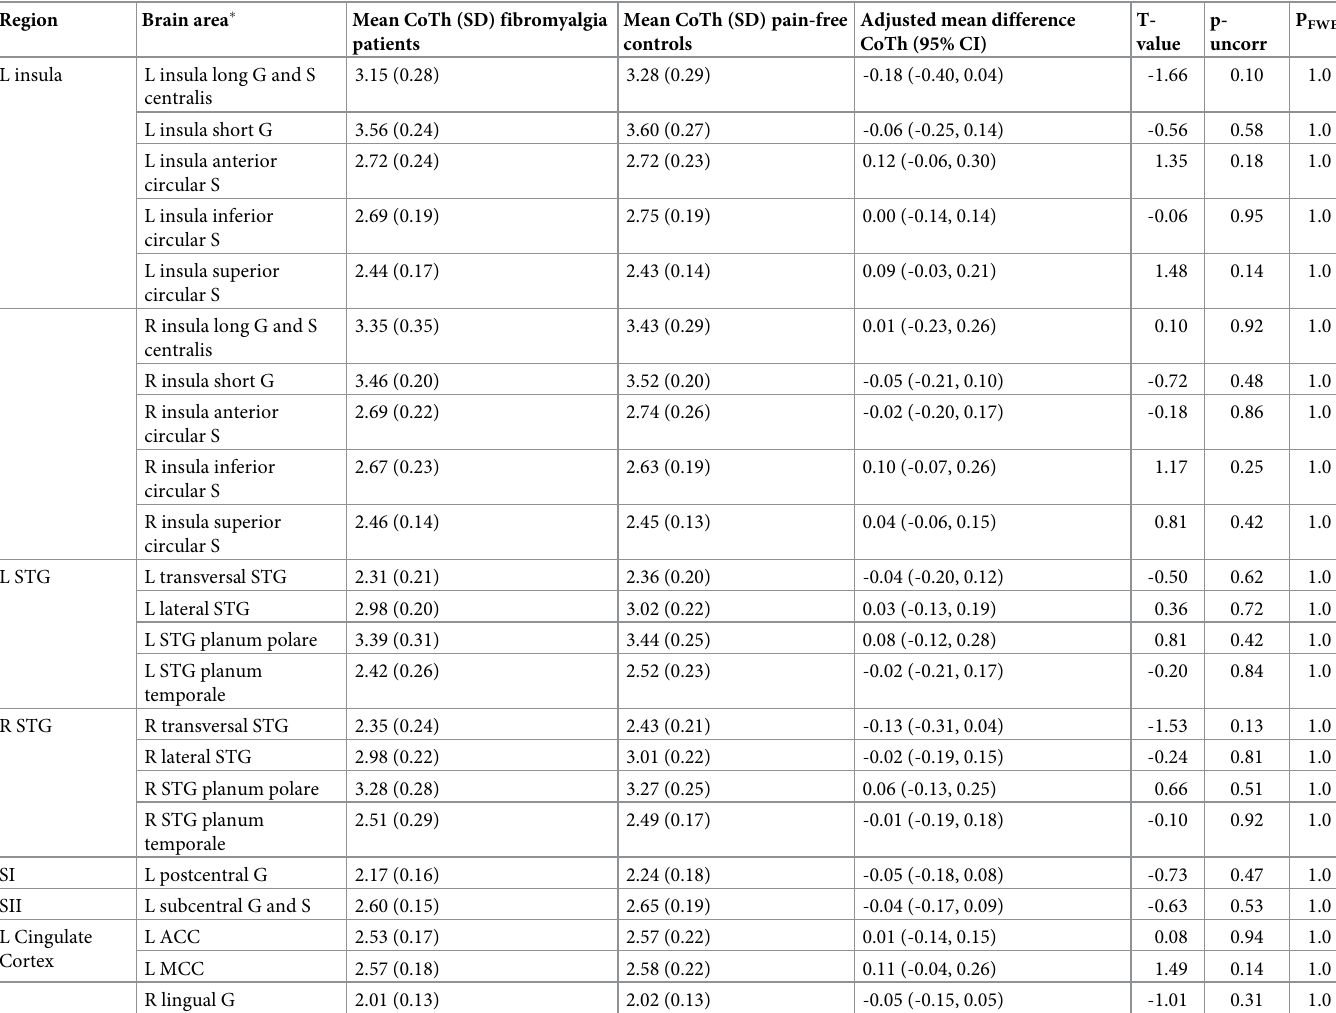
Table 4. Adjusted differences in cortical thickness (CoTh, mm) between 32 fibromyalgia patients and 32 pain-free controls in 23 pre-specified Regions of Interest. Region Brain area � Mean CoTh (SD) fibromyalgia